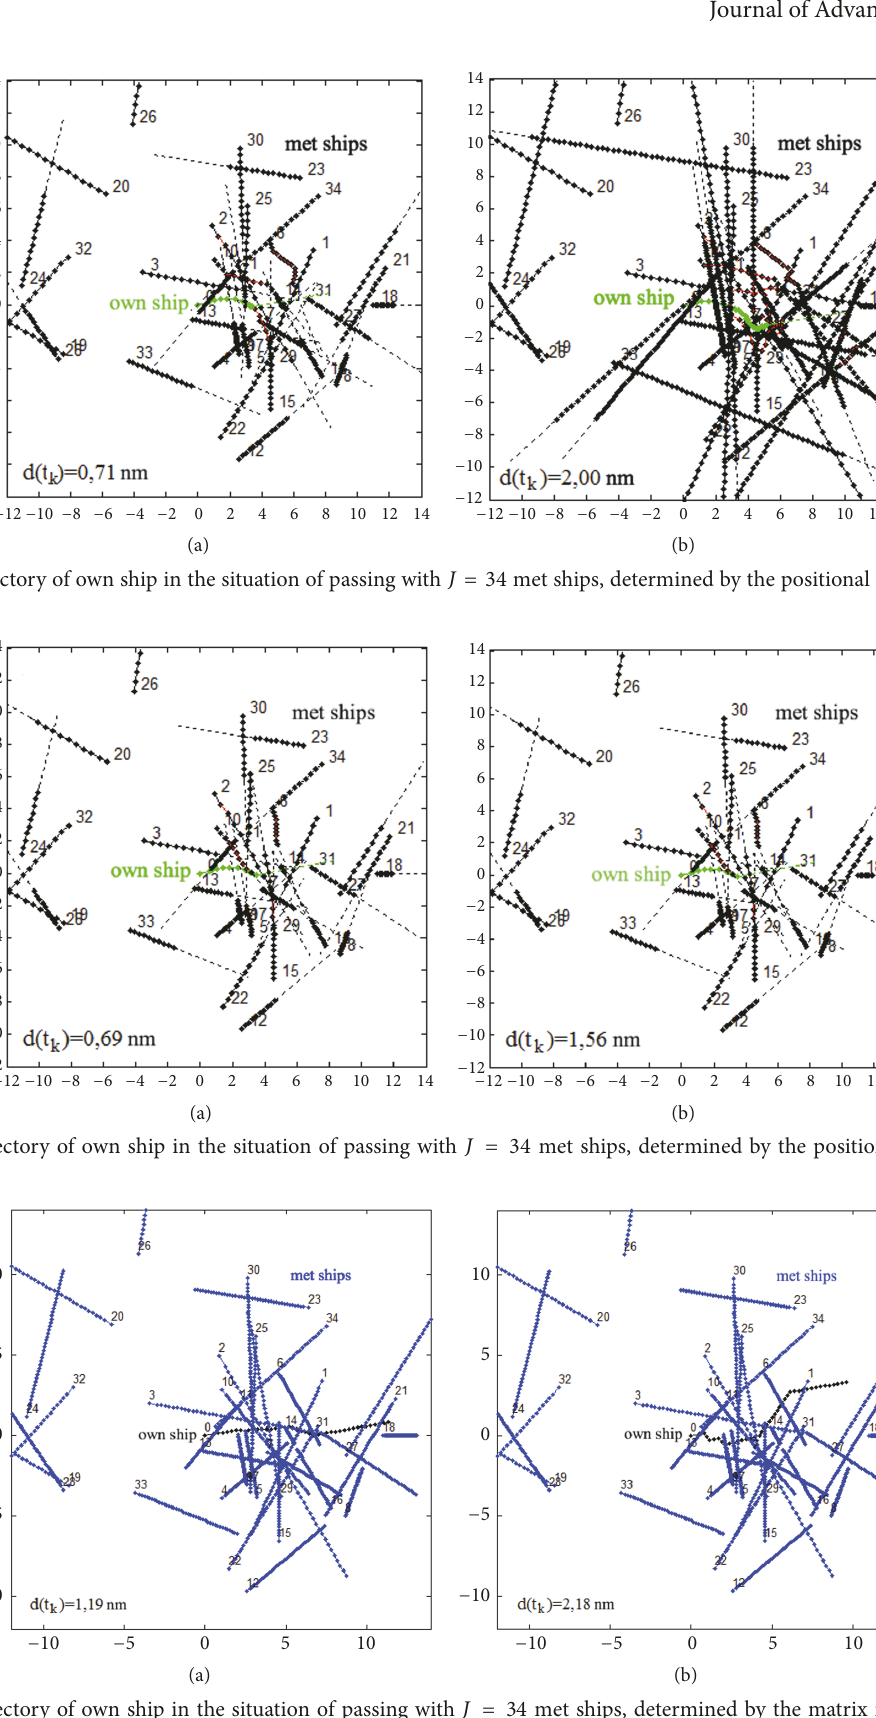
Figure 6: Safe trajectory of own ship in the situation of passing with 𝐽 = 34 met ships, determined by the matrix noncooperative game